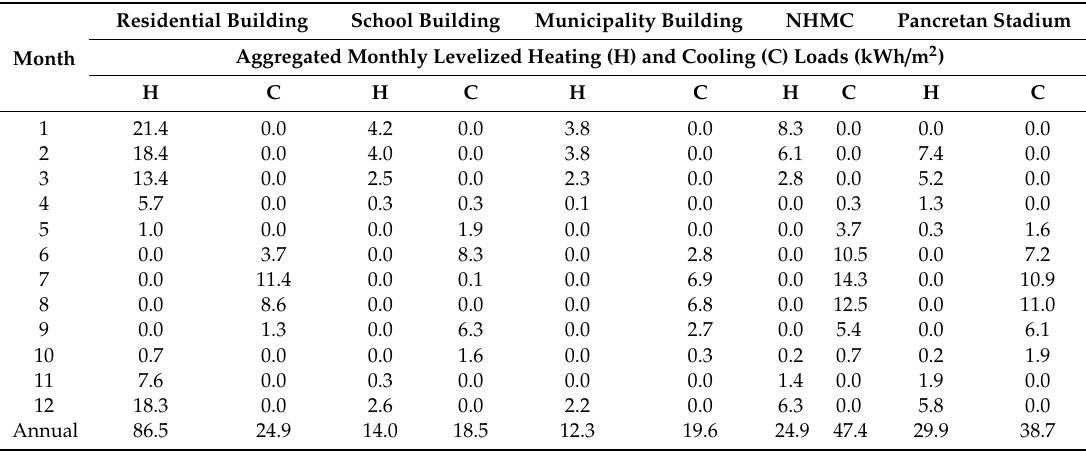
Table 6. Heating and cooling loads monthly analysis, levelized per m 2 of indoor conditioned space, after the integration of the proposed passive measures.